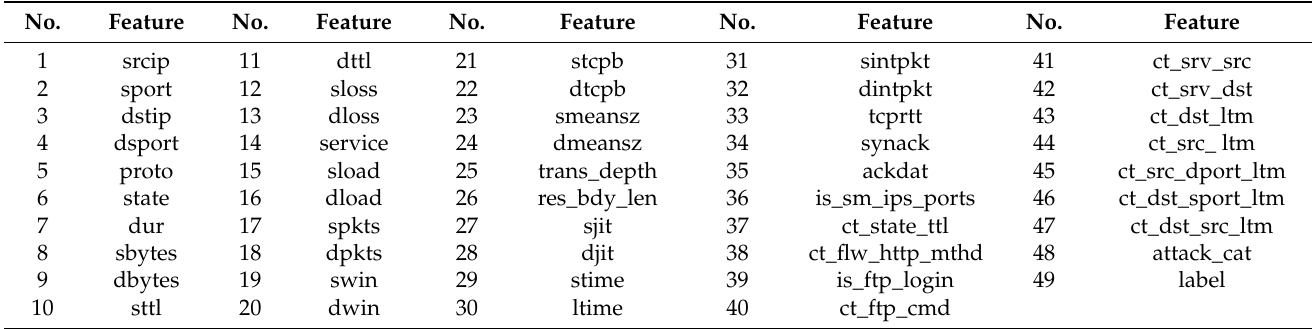
Table 1. List of features in the UNSW-NB15